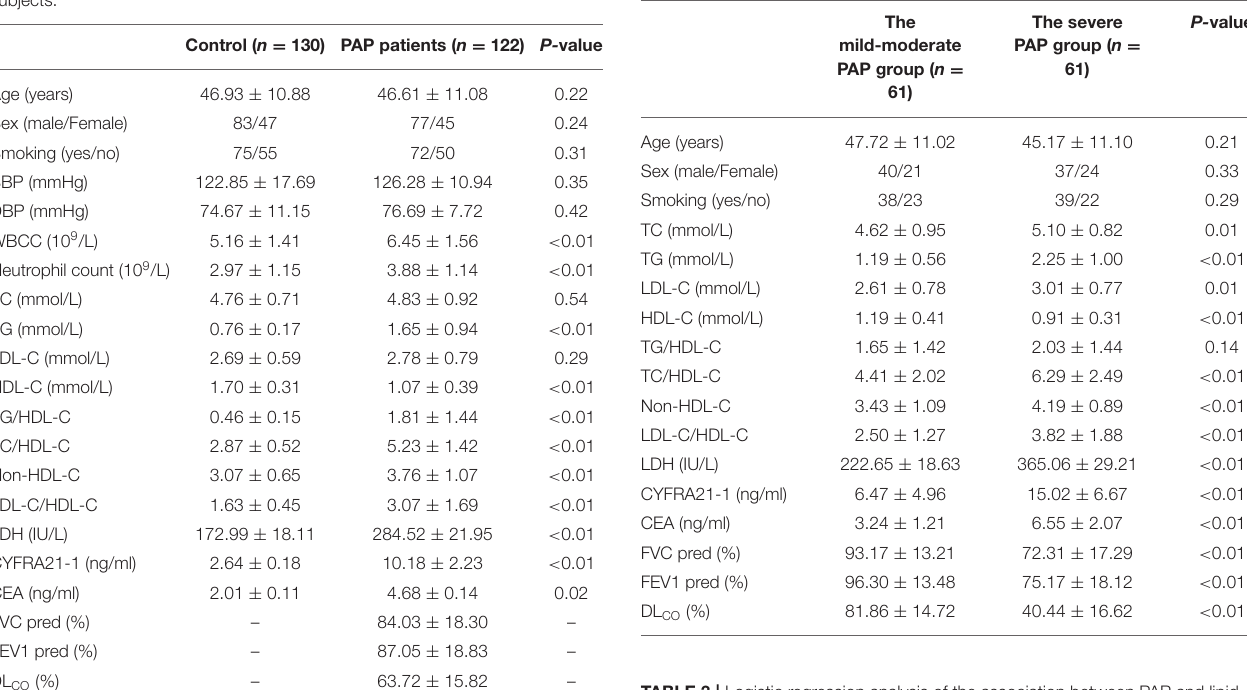
TABLE 3 | Logistic regression analysis of the association between PAP and lipid ratios.